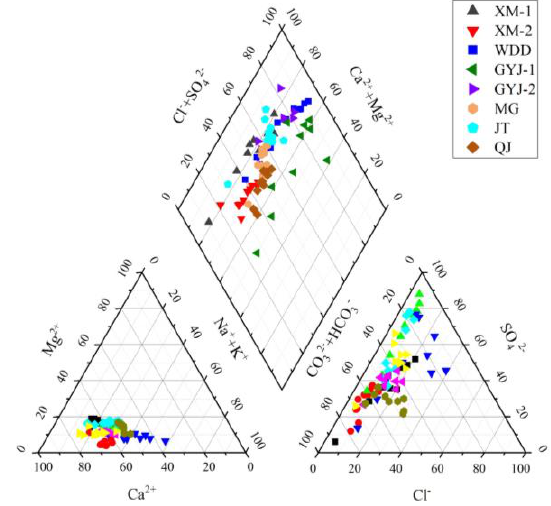
Figure 3. Piper diagrams of soil-soluble salt in the study area.